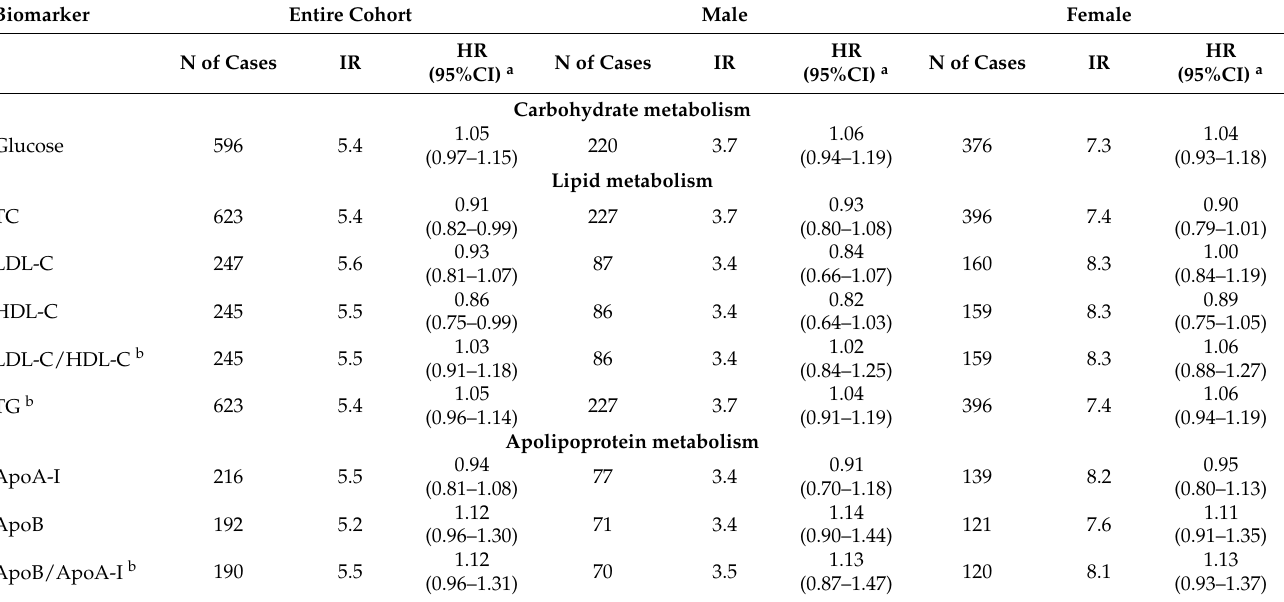
Table 3. Incidence rate (IR) per 100,000 person-years and hazard ratio (HR) with 95% confidence interval (CI) of thyroid cancer per SD increase in blood lipid, carbohydrate, and apolipoprotein